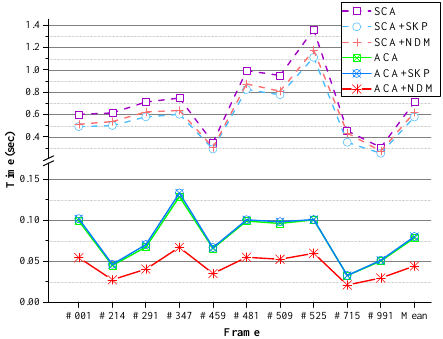
Figure 14. Comparison of runtimes using the selected Tsukuba Stereo Dataset. Table 4. Quantitative evaluation results for comparing internal algorithms of the ACA-based method on the selected Tsukuba Stereo Dataset. The best performance is highlighted in bold. SCA, synchronous cellular automata; SKP, skipping method; NDM, neighborhood distance map.